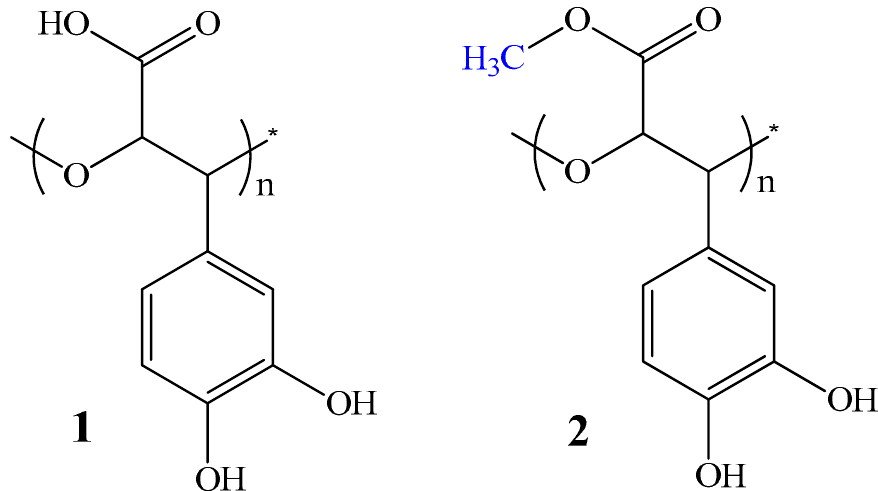
Figure 1. Poly[3-(3,4-dihydroxyphenyl)glyceric acid] (PDHPGA) ( 1 ) and poly[2-methoxycarbonyl-3-(3,4-dihydroxyphenyl)oxirane] (PMDHPO) ( 2 ). The polyoxyethylene (polyethylene glycol) chain is the backbone of polymeric molecule PDHPGA. 3,4-Dihydroxyphenyl (catechol) and carboxyl groups are regular substituents at two carbon atoms in the chain of PDHPGA [26]. On the other hand, a poly (2,3-glyceric